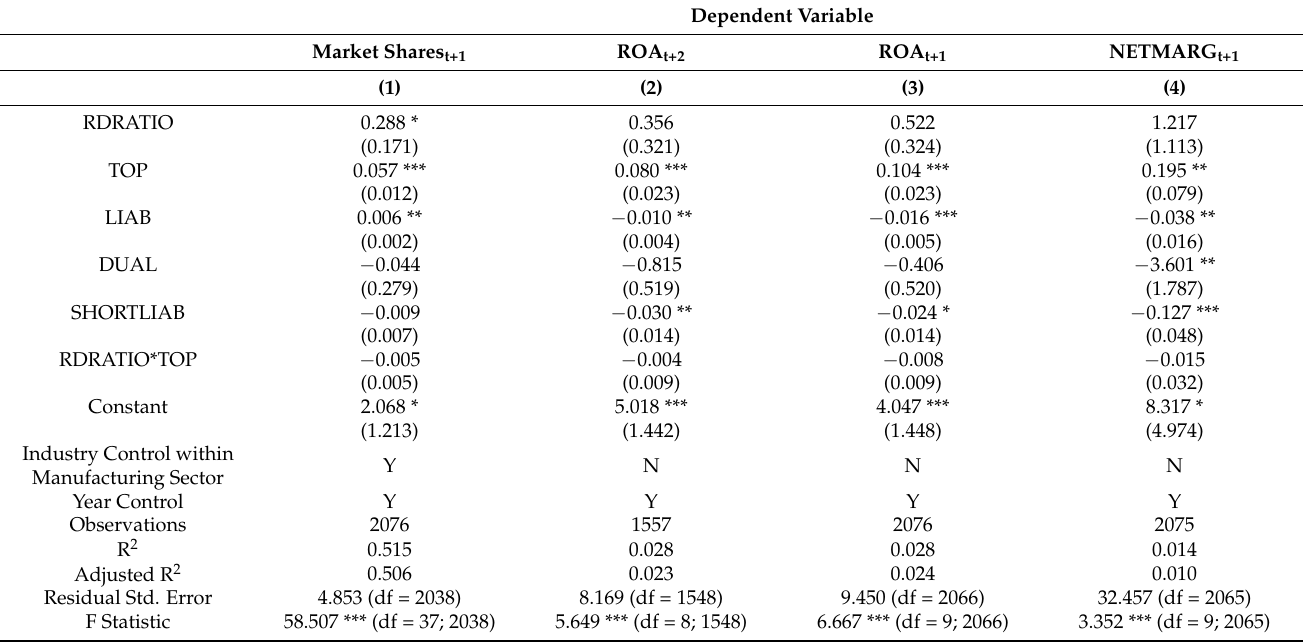
Table 6. Shanghai exchange listed firms.